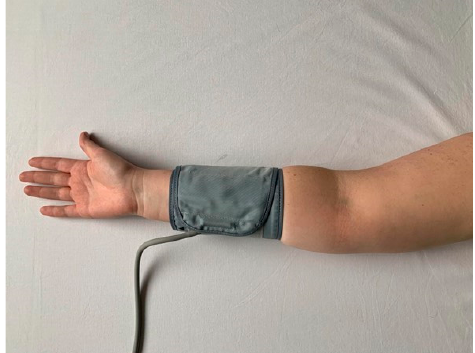
Figure 2. Distal location of the cuff.